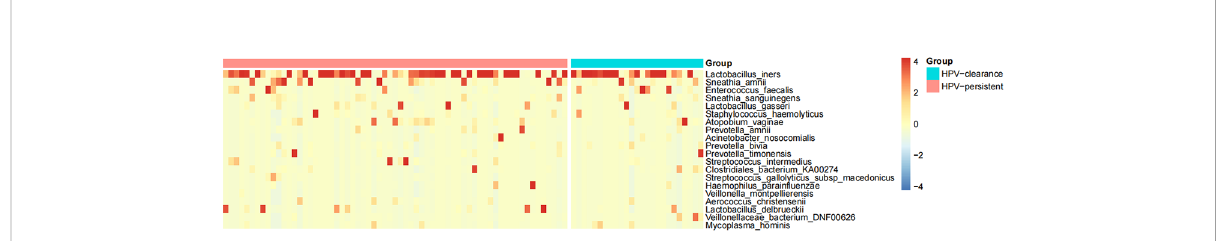
FIGURE 11 Heat map analysis of bacterial species found in the vaginal fl ora of 90 women. Each vertical line represents one sample. Different colors indicate relative abundance: red represents a high proportion and blue represents a low proportion. HPV-clearance: patients who cleared HPV; HPV- persistent: patients who did not clear HPV.